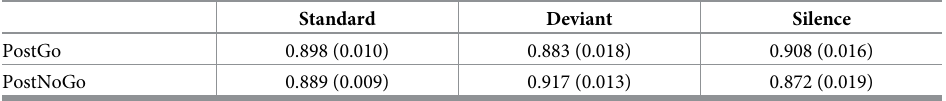
Table 1. Mean proportion of correct responses as a function of trial (postGo, PostNoGo) and sound (standard, deviant, silence) conditions. Values within parentheses represent one standard error of the mean.